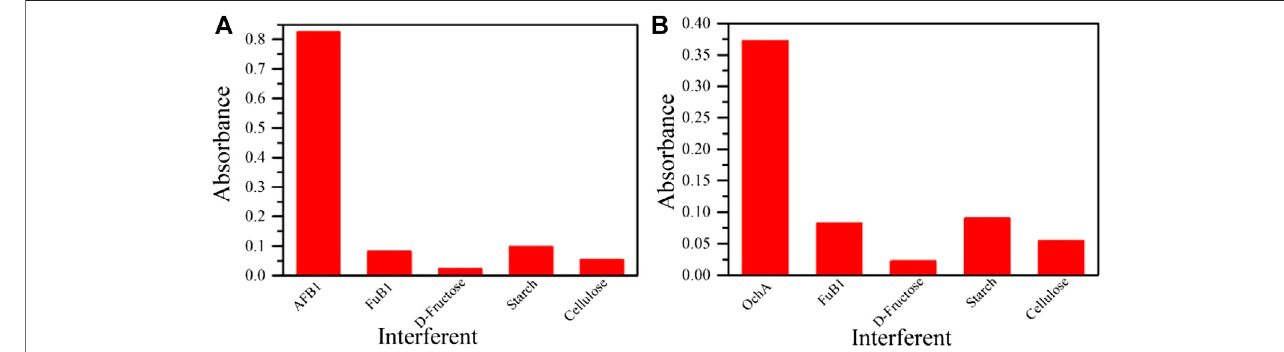
FIGURE 8 | Selectivity studies of (A) AFB1 and (B) OchA.